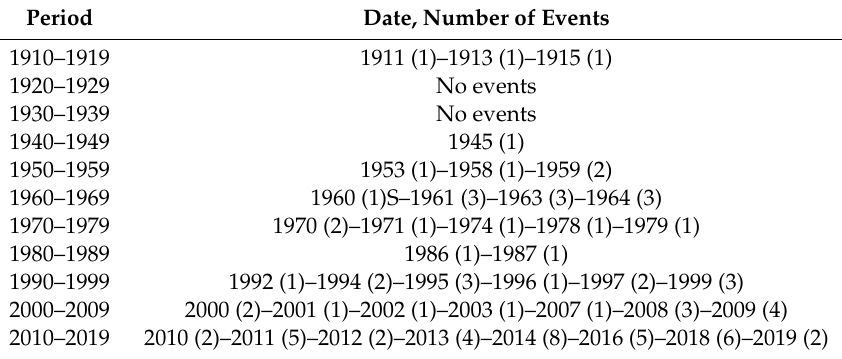
Table3. Rainfalleventstriggeringshallowlandslidesandmud-debrisflowsonthePortofinopromontory starting from the year 1910, organized in decades. For each year, the number in round brackets represents the number of rainfall events that triggered